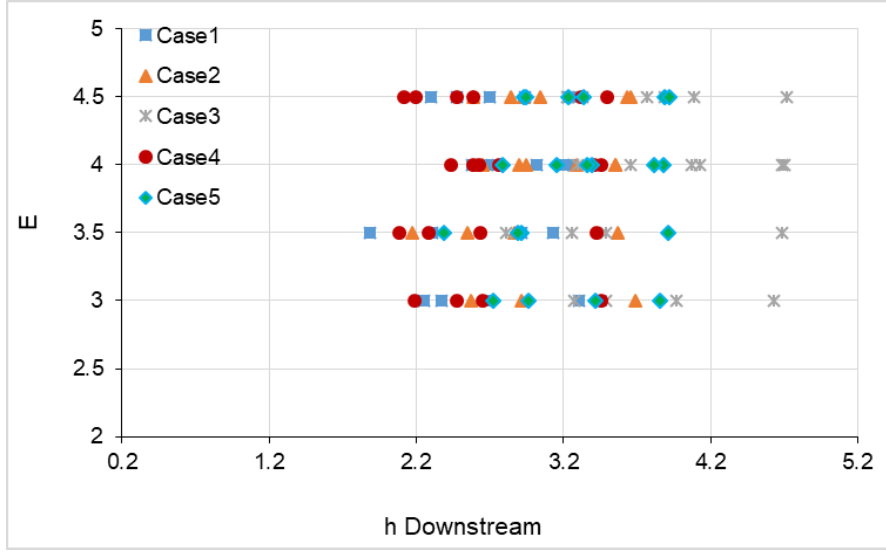
Figure 13. The relation between specific energy and average water depth at downstream